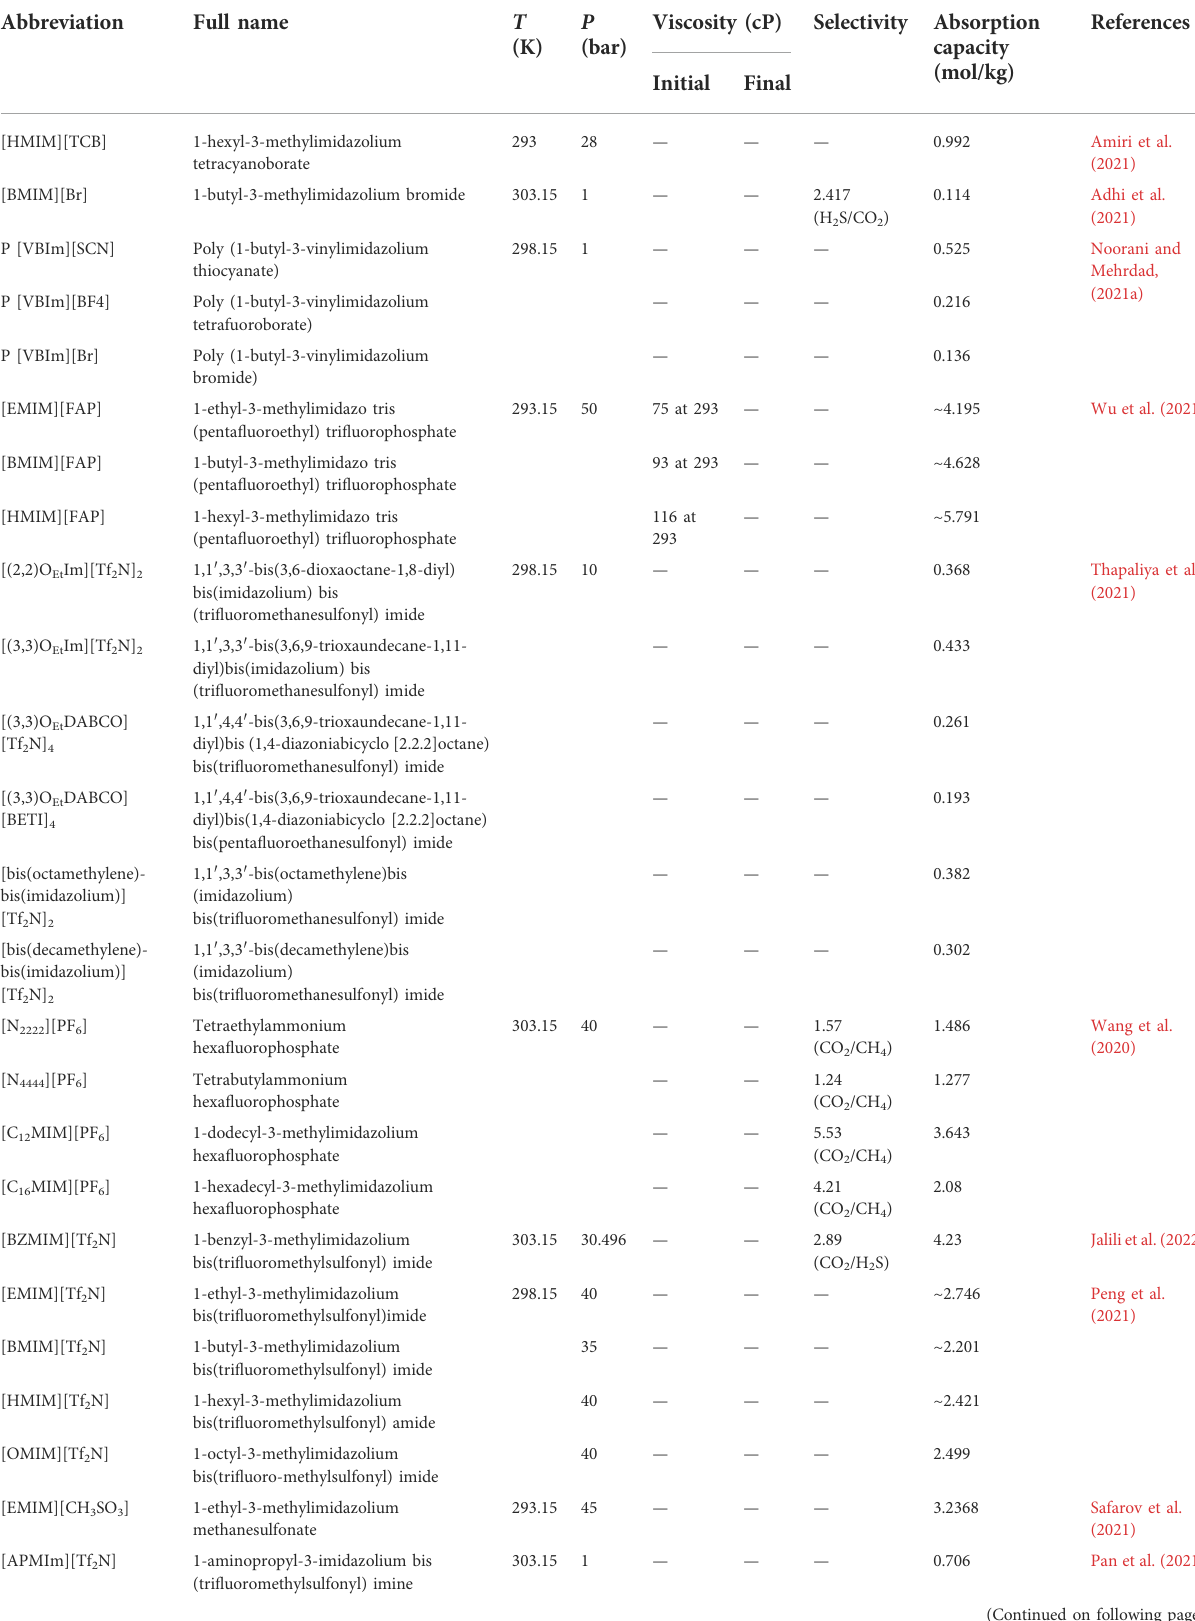
TABLE 1 Physical-based ILs reported in 2021 –